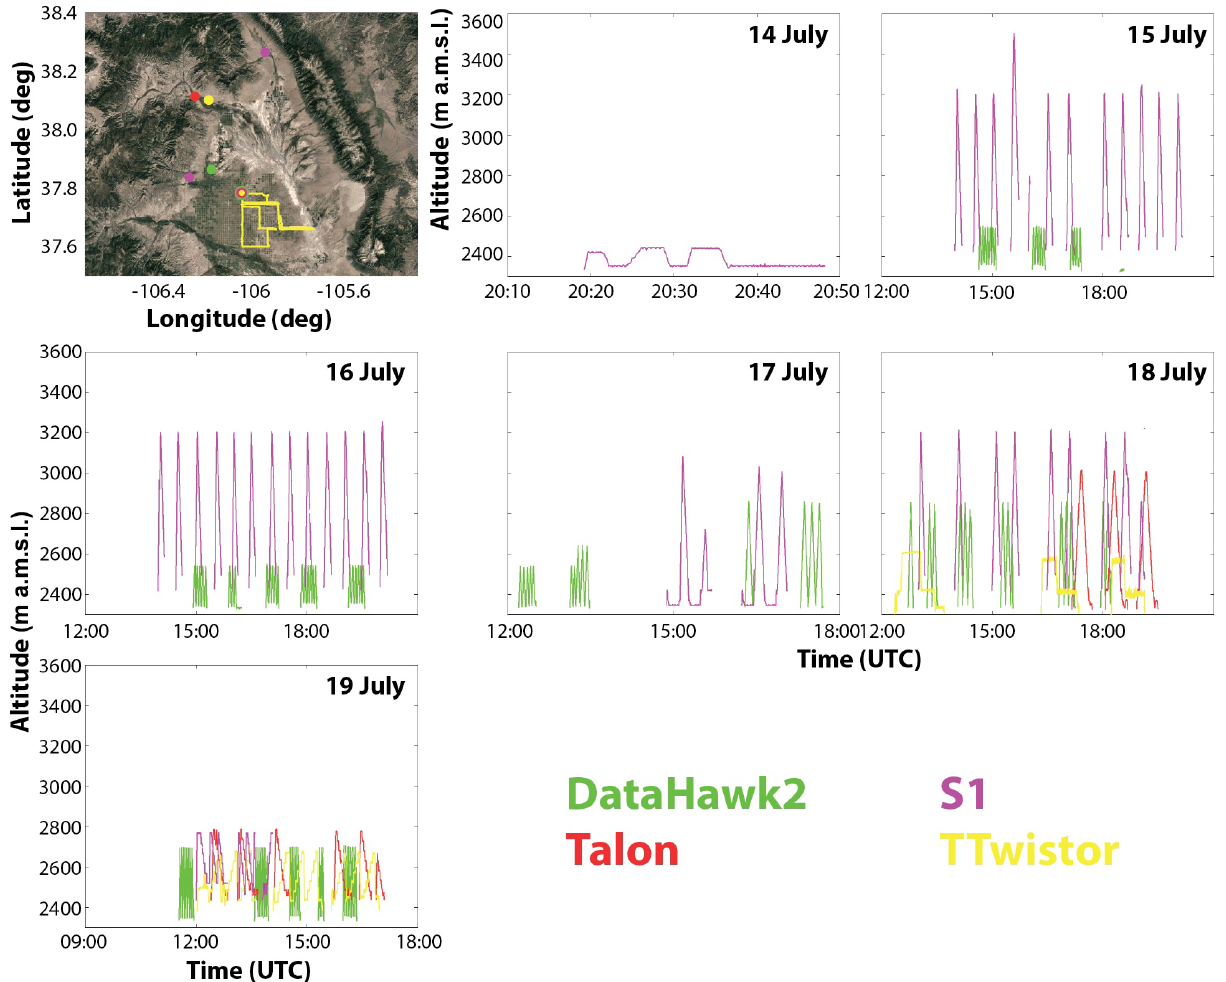
Figure 2. The flight locations for each aircraft (left) and altitudes covered by the different aircraft broken down by day (right). Map back- grounds are © Google Maps 2021 and downloaded through their